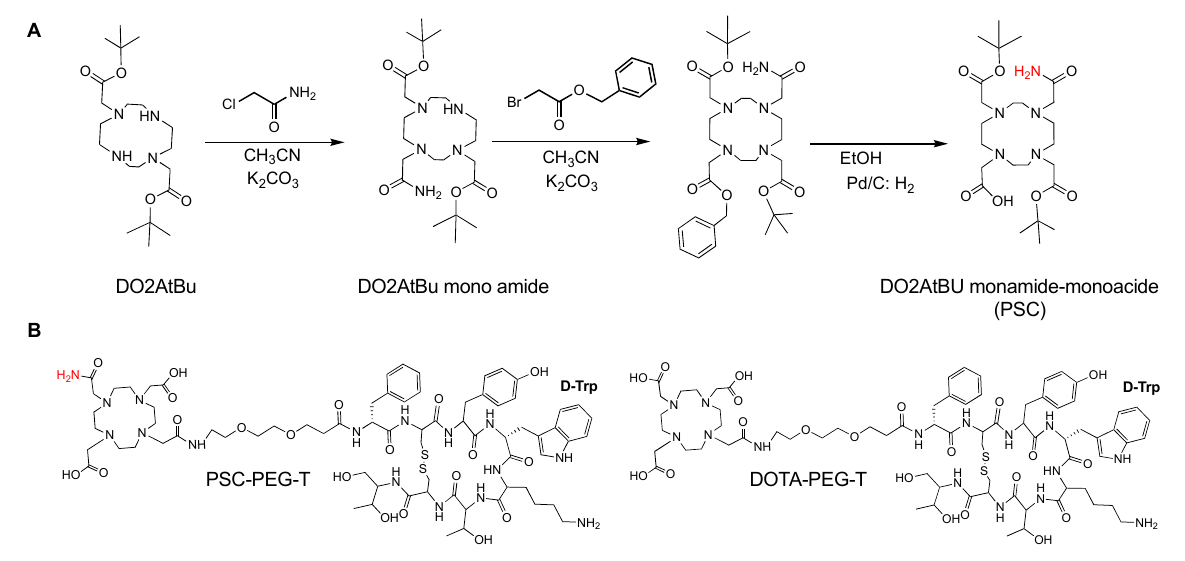
Figure 1. ( A ) Structure and synthesis scheme of PSC chelator; ( B ) Structure of PSC or DOTA conju- gated tyr3-octreotide analogue PSC-PEG-T and DOTA-PEG-T. DO2AtBu mono amide (0.02 mole; 10.0 g) was dissolved in 100 mL of CH 3 CN. Then, 9.1 g of K 2 CO 3 (0.07 mole) was added in the solution and the mixture was stirred at room temperature. Next, 5.0 g of benzyl bromoacetate was added to mixture and the solution was stirred at room temperature for 12 h. The mixture was filtered off and solvent evaporated to obtain a pale-yellow oil which was dissolved in 100 mL of ethanol with 10 mL of water. Hydrogenation was conducted by adding 0.1 g Pd/C (palladium on carbon) and mixing under hydrogen atmosphere. After 12 h, Pd/C was removed by filtration and solvents evaporated. Residue was taken up with acetone. The obtained precipitate was purified by filtering off, and PSC was obtained as a colorless solid (5.6 g, yield 50%). Purity (98.5%) and identity of final PSC product were characterized by LC-MS on Thermo Scientific U3000 equipped with a DAD for UV spectrometer and MSQ Plus mass spectrometer, running 5% H 2 O with 0.1% TFA over acetonitrile over 1.5 min on Kinetex C-18 column 2.6 µ m, 100A, 50 × 2.1 mm (Phenomenex, Torrance, CA, USA) at 0.5 mL min − 1 . 1 H and 13 C NMR characterization of PSC was conducted. 1 H NMR (600 MHz, DMSO, 323 K): d (ppm) 1.42 (s, 18H); 2.56 (s (br), 4H); 2.75 (s (br), 4H); 2.93 (s (br), 4H); 3.05 (s, 2 H); 3.16 (s (br), 4H); 3.35 (s, 4H); 3.40 (s, 2H) 6.80 (s, 1H); 7.59 (s, 1H). 13 C NMR (150 MHz, DMSO, 323 K): d (ppm) 27.7; 47.6; 49.7; 52.1; 52.2; 54.6; 56.6; 57.5; 80.3; 166.4 (br); 170.0; 172.5. Calculated elemental composition of PSC (C 24 H 45 N 5 O 7 ) was 2.7 H 2 O C: 51.08%; H: 9.00%; N: 12.41%; the actual elemental analysis demonstrated C: 50.85%; H: 9.39%; N: 12.16%. PSC or DOTA was conjugated to the N-terminus of octreotide analogue TOC via PEG2 linker (Figure 1B). PSC-PEG-T was prepared by standard Fmoc procedures on a H-threoninol (But)-2-Cl-Trt-resin employing multiple coupling cycles for all amino acids. Following the coupling of the N-terminal amino acid (Fmoc-Nle-OH) on the linear peptide, Fmoc-PEG 2 -propionic acid was coupled to the N-terminus and deprotected prior to chelator coupling. Conjugation of DOTA or PSC to PEG-T was conducted by adding five equivalents of protected DOTA or PSC to sidechain-protected peptides on resin utilizing HATU/HOBt during the coupling reaction. Completed reaction was monitored by Kaiser test. Upon completion of the reaction, the resin was washed with DMF, DCM and methanol. PSC- PEG-T and DOTA-PEG-T peptides were cyclized via I 2 oxidation by treating peptides with 20 equivalents of I 2 in DMF. All peptides were removed from resin and side chain residues were deprotected by incubation in TFA/H 2 O/TIS (95/2.5/2.5%) cleavage cocktail for 2 h, followed by precipitation in ice cold diethyl-ether. The precipitate was centrifuged at 3000 rpm for 10 min at 4 ◦ C and the supernatant was decanted. The crude